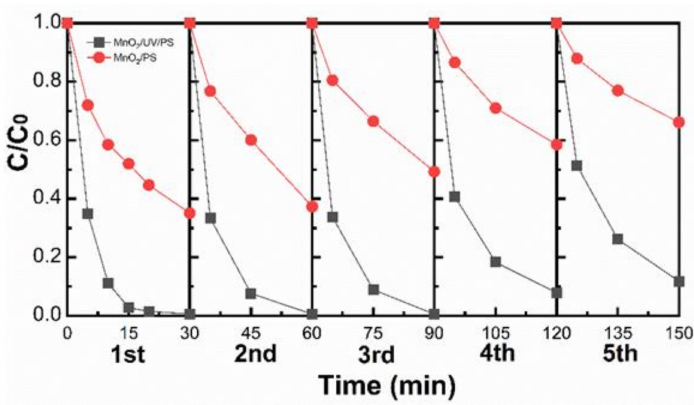
Figure 6. MnO 2 recycles in MnO 2 /PS and MnO 2 /UV/PS